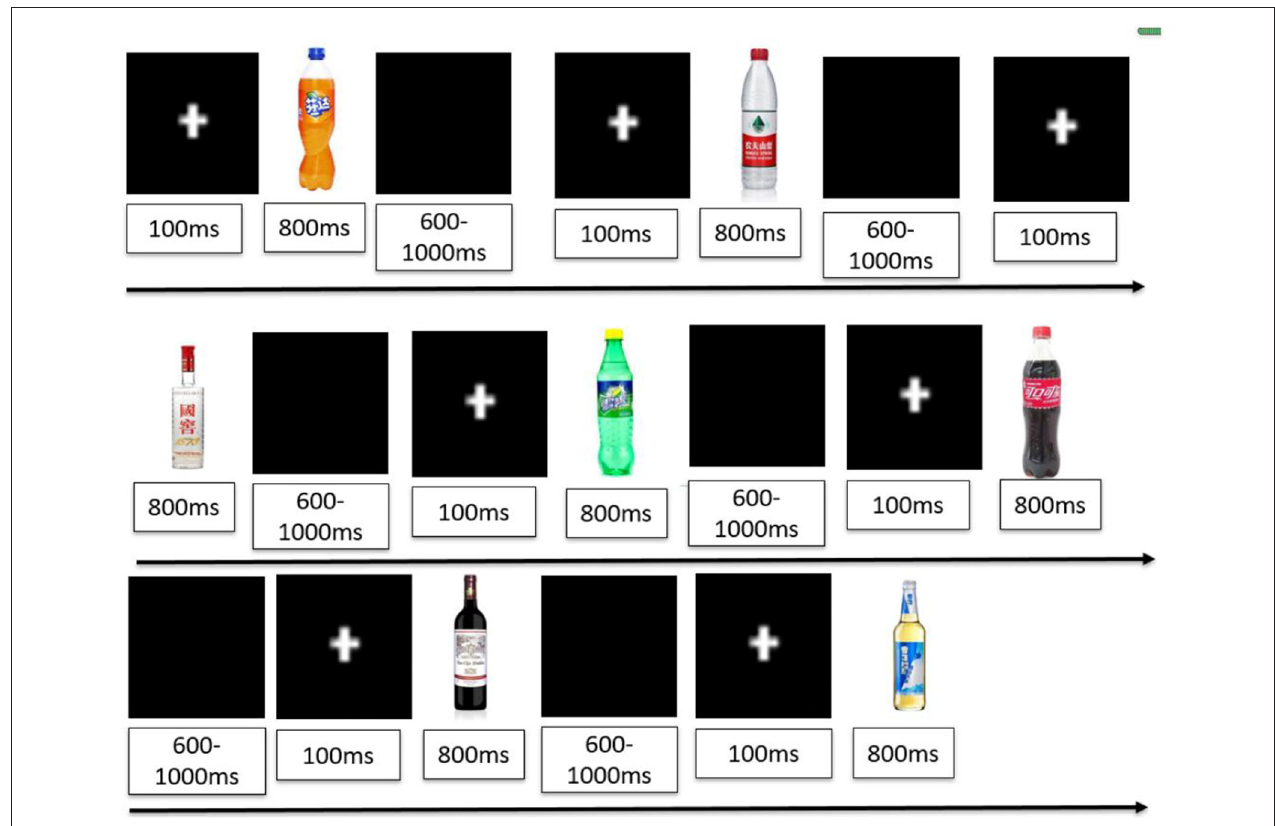
FIGURE 1 | Cue response task-visual oddball